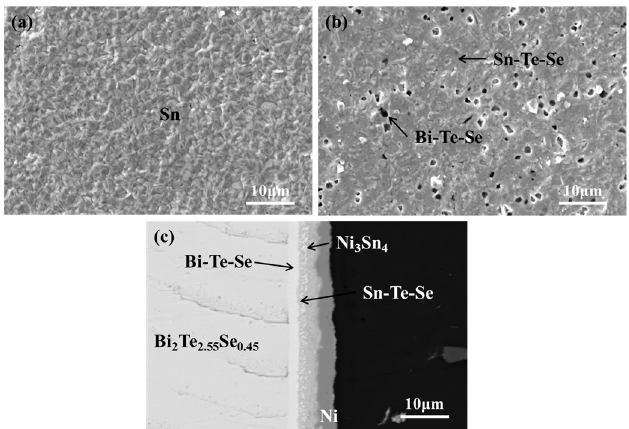
Figure 2. Surface of Bi 2 Te 2.55 Se 0.45 thermoelectric material after ( a ) electroplating with 1 μ m Sn film, ( b ) subsequent heating at 250 °C for 3 min, and ( c ) pre ‐ coated with Sn/Ni and heated 250 °C for 3 min.